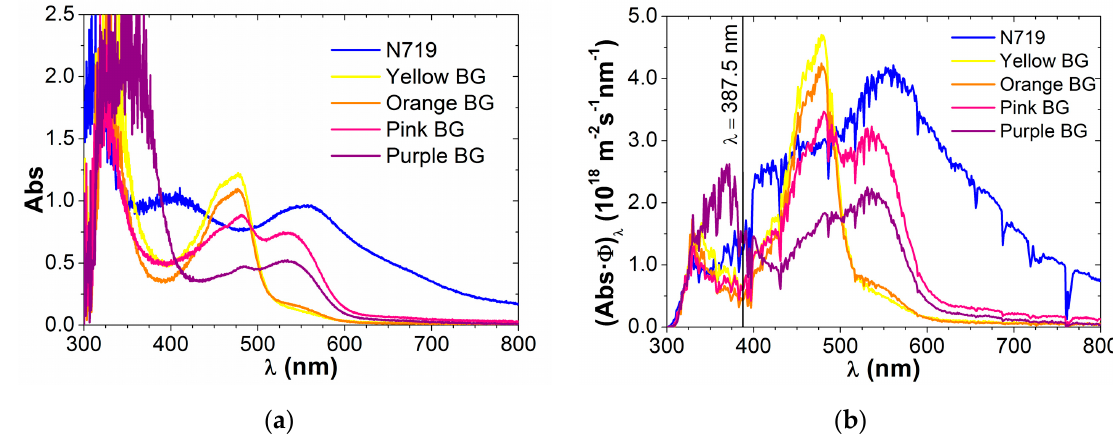
Figure 3. ( a ) UV-Vis spectra of the four bougainvillea extracts obtained. N719 spectrum is also included for comparison. ( b ) Products of all dye spectra in Figure 3a and the sun spectrum ( Φ λ ) in Figure